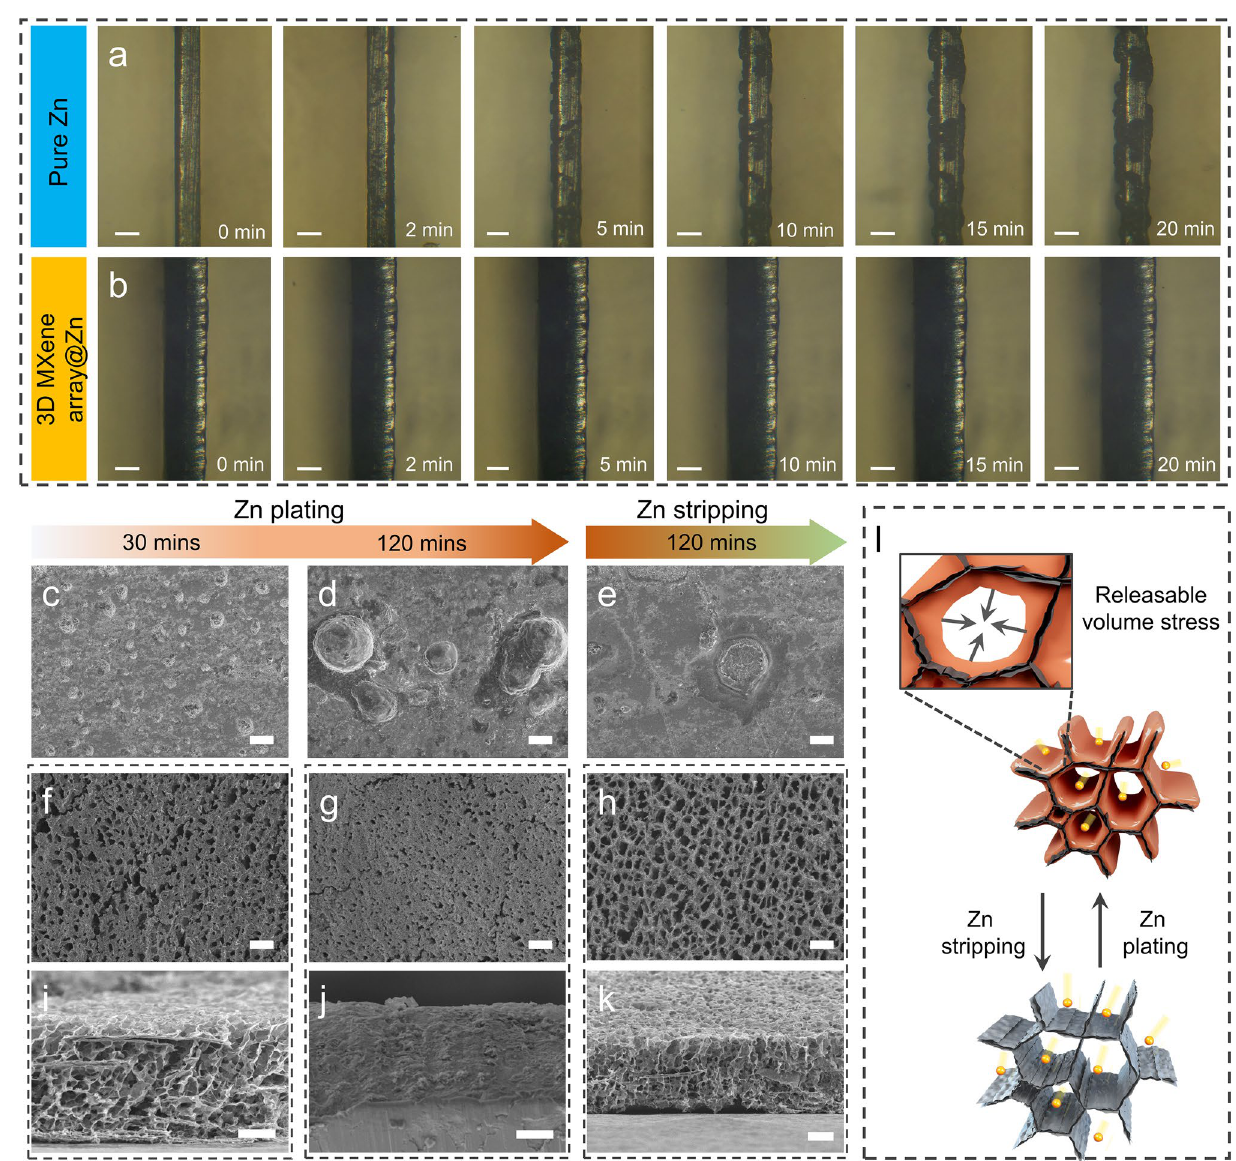
Fig. 3 In-situ optical observation of zinc deposition on a pure Zn anode and b 3D MXene array@Zn anode at different time under the current density of 10 mA cm −2 (scale bar = 100 µm). Ex-situ FESEM images of c–e pure Zn, f–h top-view and i–k side-view of 3D MXene array@Zn anode after zinc plating/stripping for different time (scale bar = 10 µm). l Schematic diagram of the surface morphology evolution of 3D MXene array@Zn electrode during zinc plating/stripping